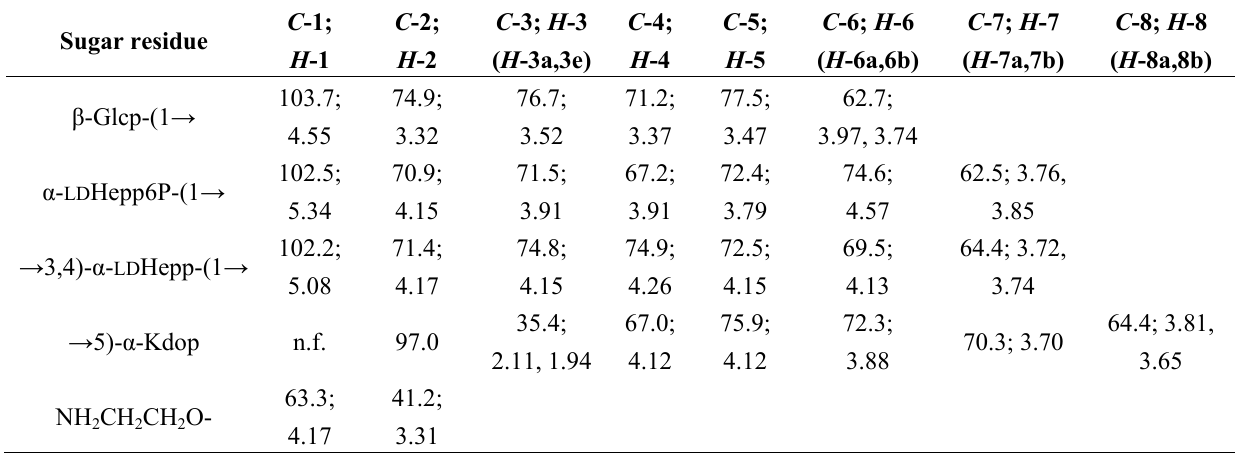
Table 1. 1 H- and 13 C-NMR chemical shifts (  , ppm) of the modified core OS from K. pneumoniae 52145∆ wabG plus pBAD18-Cm- eptC